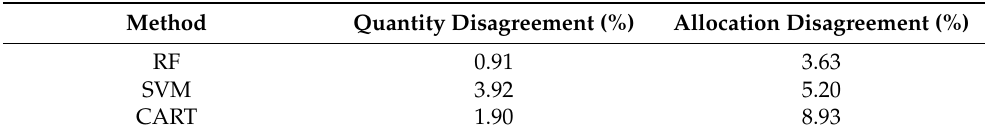
Table 5. Comparison of quantity and allocation disagreement among three methods.